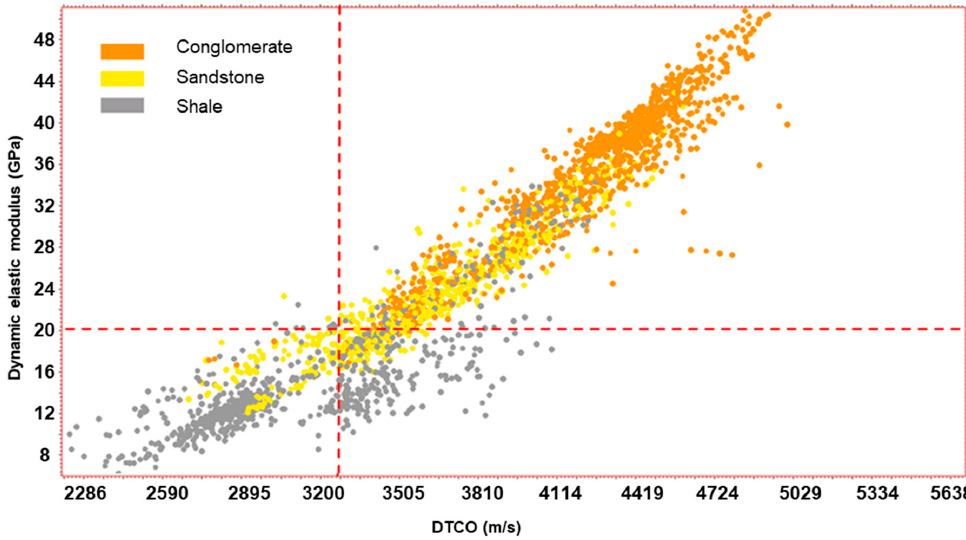
Figure 8. Cross-plot: dynamic elastic modulus and compressional wave velocity—DTCO.